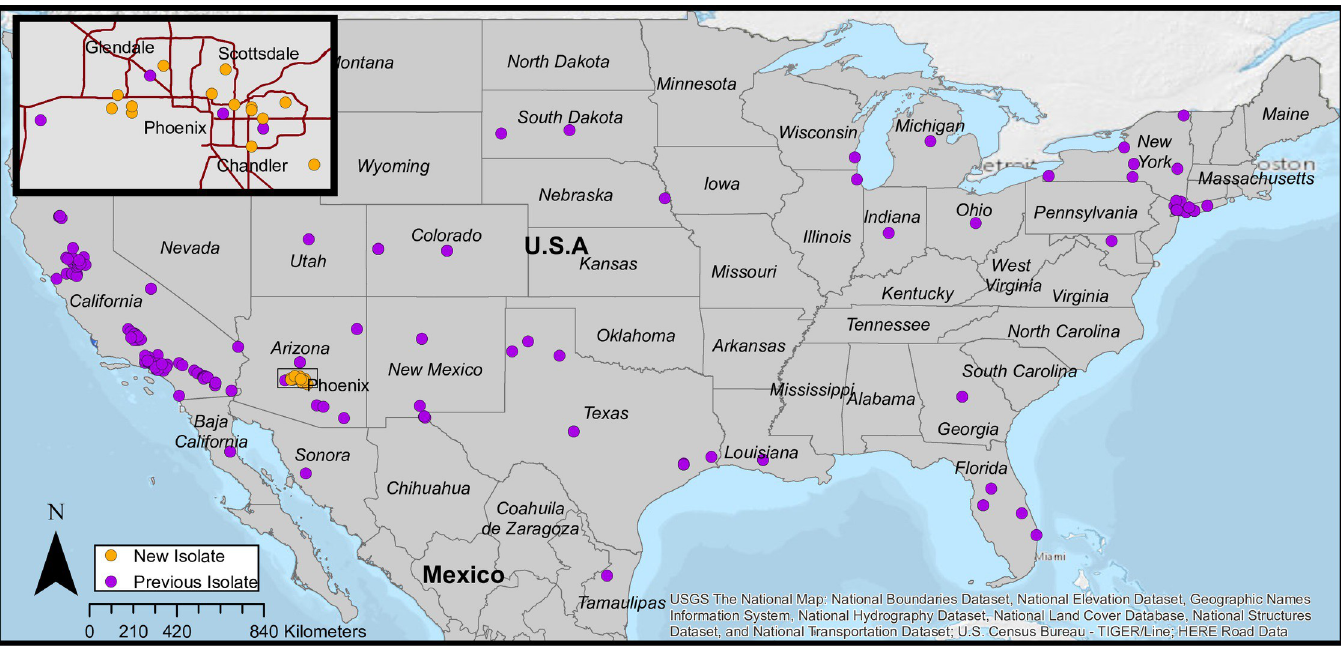
Fig 2. Geographic distribution of WNV strains included in the phylogenetic analysis, except for the New York strains published in Ehrbar et al., [17]where latitude and longitude coordinates were not available. Purple points indicate publicly available strains while orange points (inset map area shown with rectangle) indicate strains that were sequenced as part of this study. Additional metadata can be found in S1 Table. The USGS Topo was used as a basemap for this figure (USGS The National Map: National Boundaries Dataset, National Elevation Dataset, Geographic Names Information System, National Hydrography Dataset, National Land Cover Database, National Structures Dataset, and National Transportation Dataset; U.S. Census Bureau—TIGER/Line; HERE Road Data. Data Refreshed July, 2017). The final map was created using ArcGIS software by Esri. ArcGIS and ArcMap are the intellectual property of Esri and are used herein under license. Copyright Esri. All rights reserved.